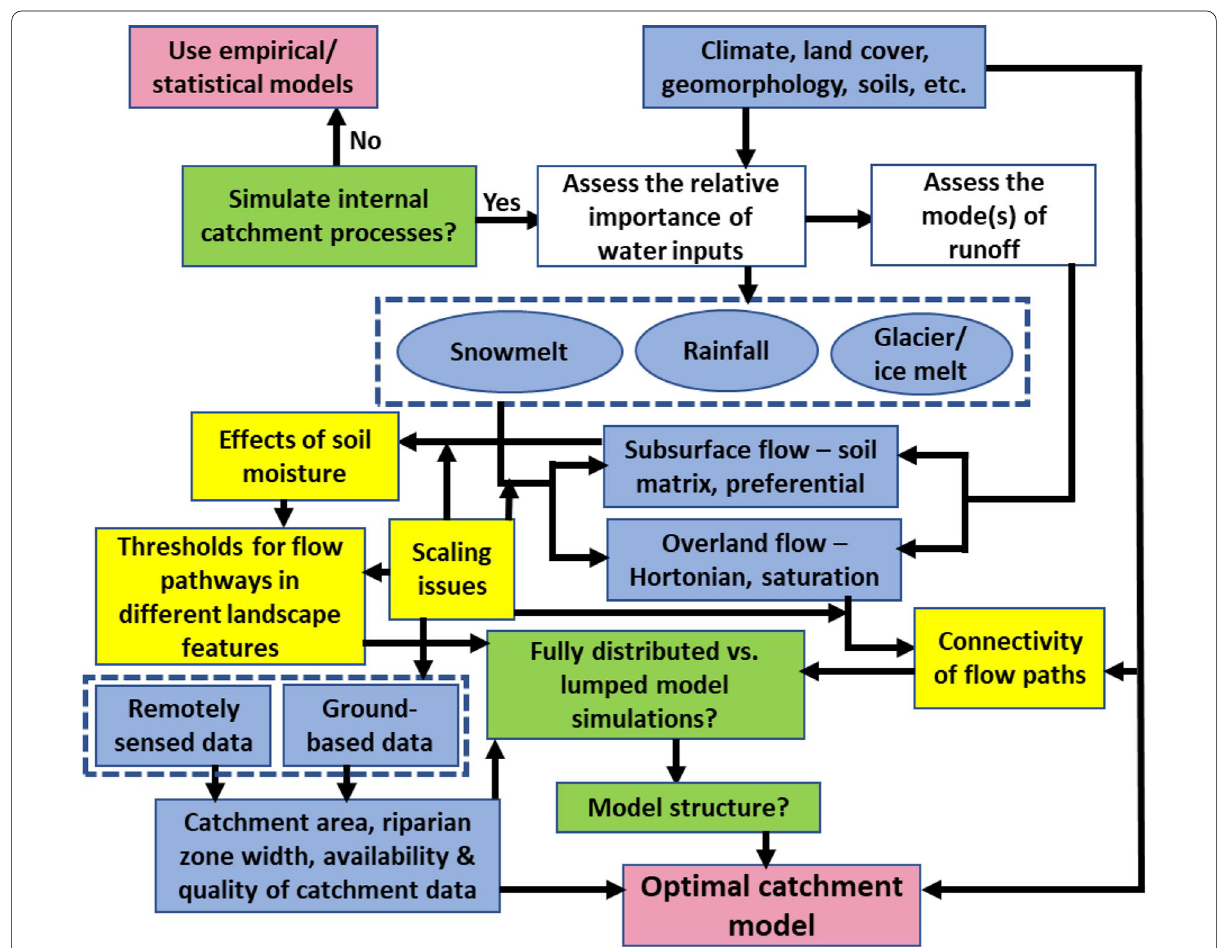
Fig. 2 A framework for illustrating where improvements (yellow boxes) can be achieved in catchment models, as well as requirements for hydrological process representation (blue boxes), broad assessment objectives (white boxes), and major decision points (green boxes) that lead to most optimal and most parsimonious model selection (pink